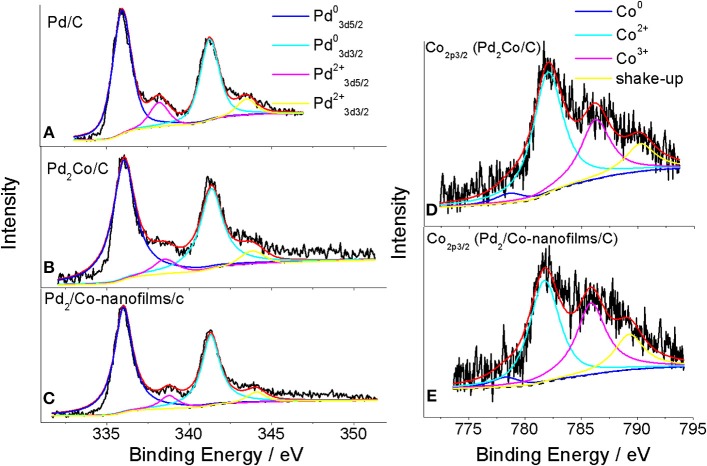
XPS spectra of Pd32d (A) for Pd/C, Pd3d (B,C) and Co2p (D,E) for Pd2Co/C and Pd2/Co-nanofilms/C catalysts. The black solid lines are the measured XPS responses. The black dashed lines are the background determined with the Shirley function. The red lines are the superposition of the deconvoluted component spectra and the background.